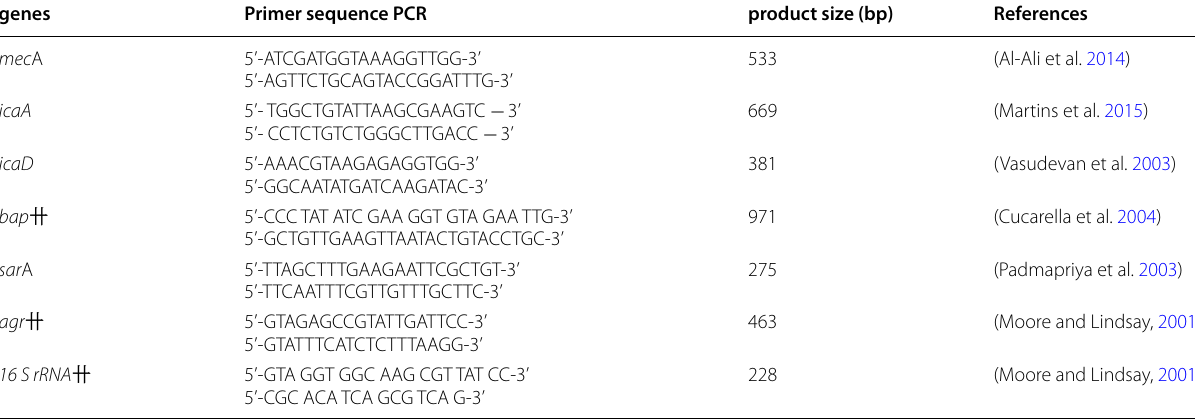
Table 2 The primers were used to screen the presence of the mecA and genes encoding adhesion factors and biofilm